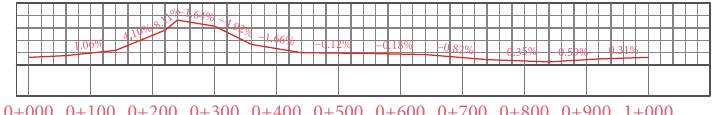
Figure 15: Profile of the path on route 3 in Tychy.